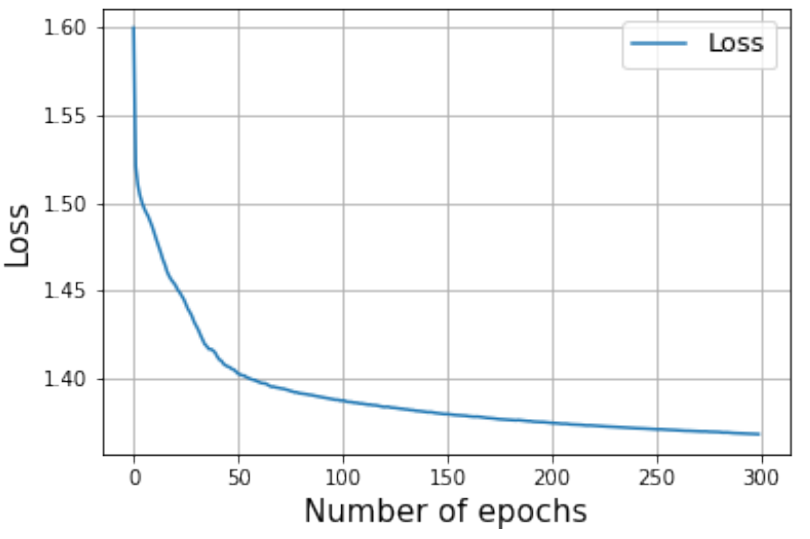
Figure 22. Illustrates the loss